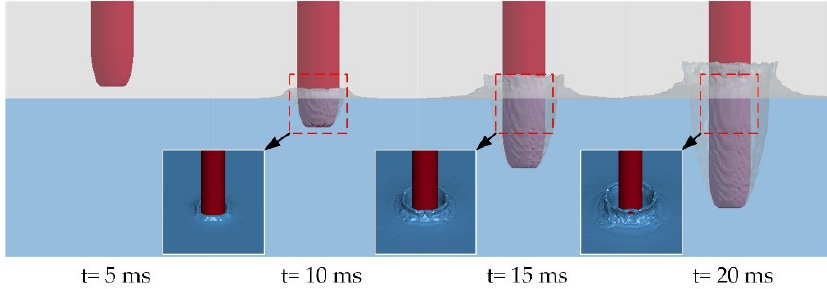
Figure 11. Cavity of vehicle entering water at speed of 100 m/s without head cap.